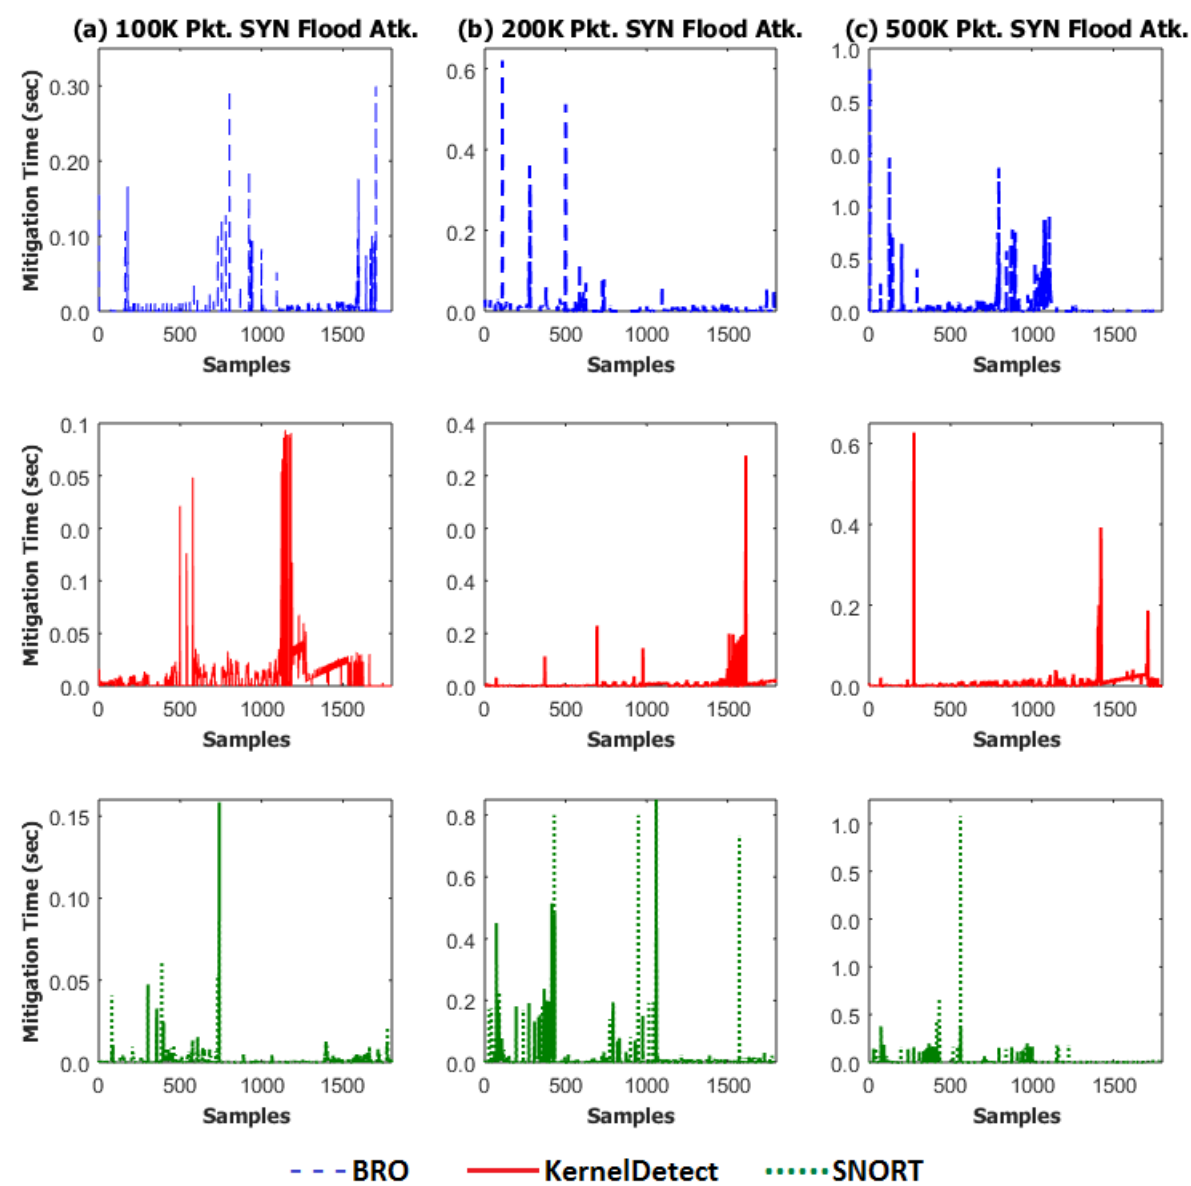
Figure 7. Threat mitigation time for each IDS under 100K, 200K and 500K SYN flagged packet DoS attack using a 5 second